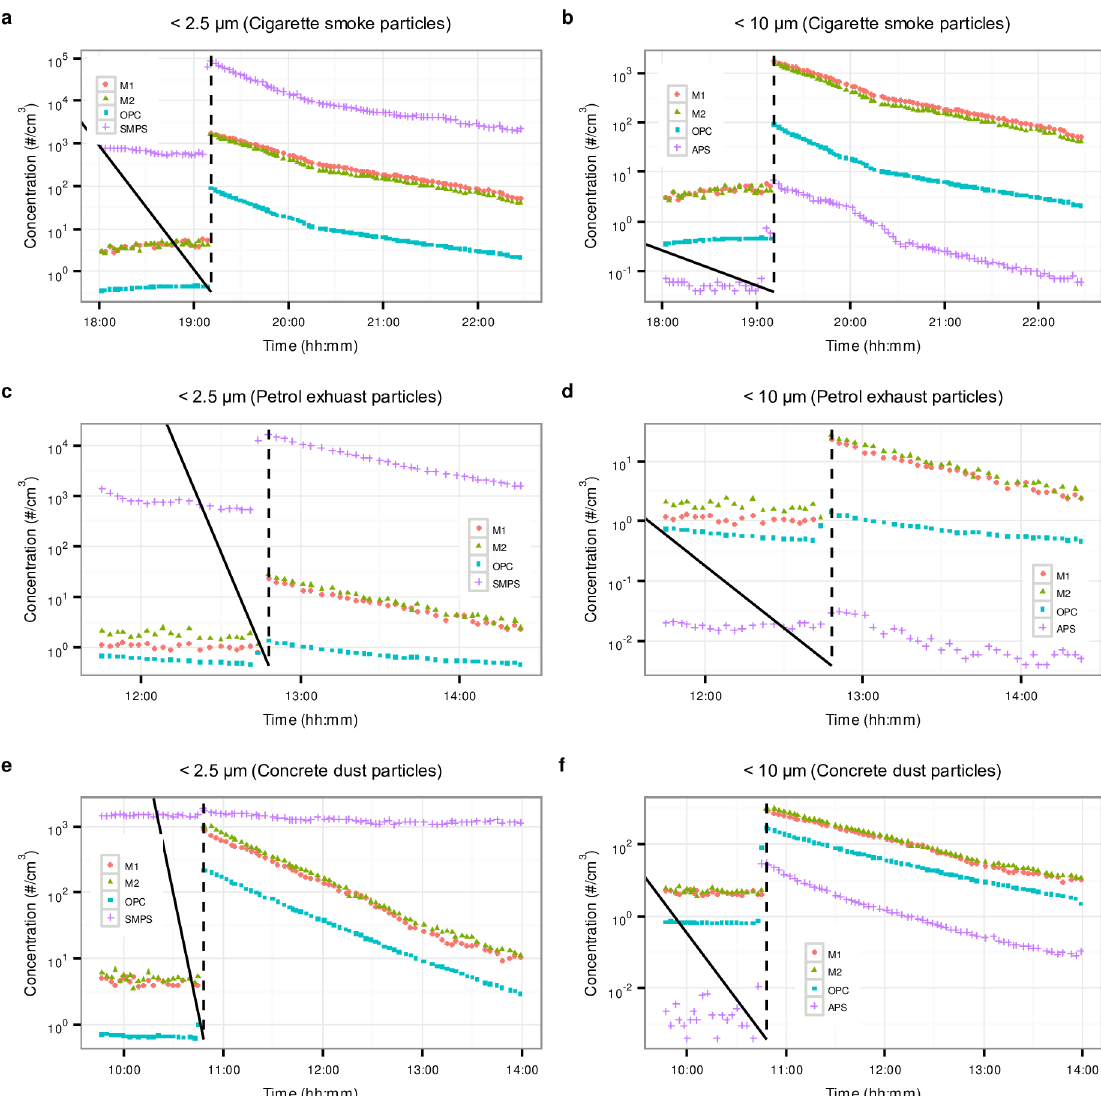
Fig 3. Time series of particles number concentrations measured during the chamber experiments. a) Cigarette smoke particles in the size fraction: M1 (cid:20) 2.5 μm, M2 (cid:20) 2.5 μm, OPC (cid:20) 2.1 μm and SMPS = total PNC. b) Cigarette smoke particles in the size fraction: M1 (cid:20) 10 μ m, M2 (cid:20) 10, OPC (cid:20) 7 μ m and APS = total PNC. c) Petrol exhaust particles in the size fraction: M1 (cid:20) 2.5 μ m, M2 (cid:20) 2.5 μ m, OPC (cid:20) 2.1 μm and SMPS = total PNC. d) Petrol exhaust particles in the size fraction: M1 (cid:20) 10 μm, M2 (cid:20) 10 μm, OPC (cid:20) 7 μm and APS = total PNC. e) Concrete dust particles in the size fraction: M1 (cid:20) 2.5 μm, M2 (cid:20) 2.5 μm, OPC (cid:20) 2.1 μm and SMPS = total PNC. f) Concrete dust particles in the size fraction: M1 (cid:20) 10 μm, M2 (cid:20) 10 μm, OPC (cid:20) 7 μm and APS = total PNC. The black dotted vertical lines represent times at which the particles were introduced into the